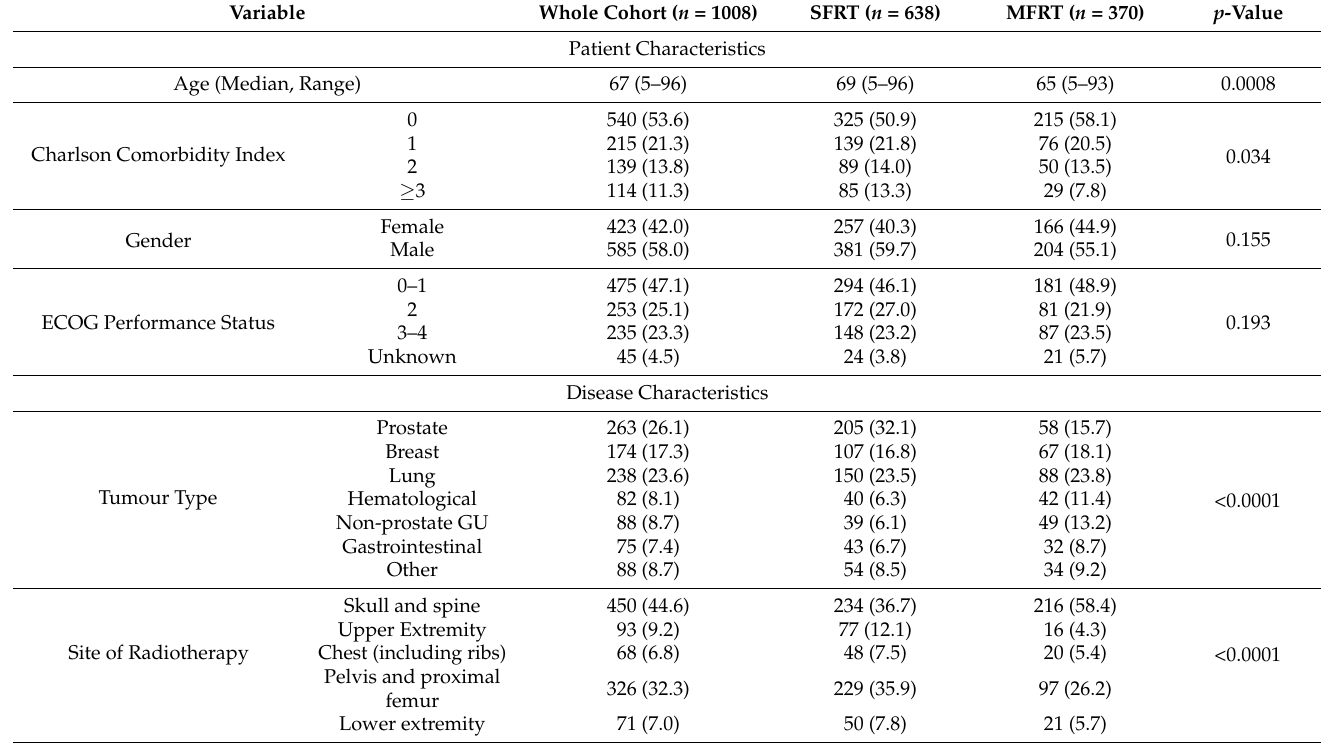
Table 1. Baseline Characteristics of overall cohort and by fractionation schedule in 2018 (SFRT vs. MFRT) (GU: Genitourinary; ECOG: Eastern Cooperative Oncology